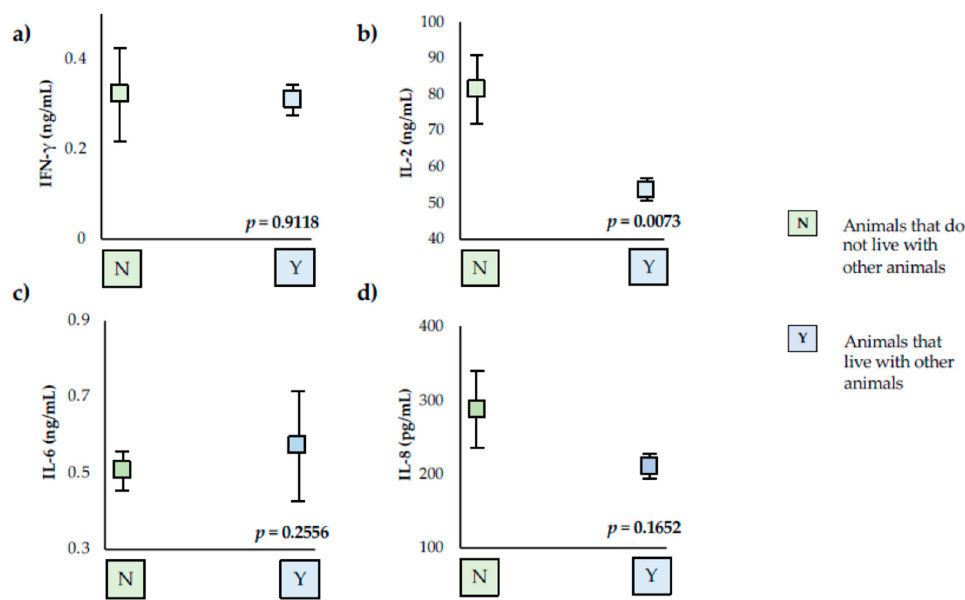
Figure 1. Serum levels of the cytokines studies in animals that do not live with other animals (N) and that live with other animals (Y). ( a ) Interferon gamma (IFN- γ ), ( b ) Interleukin 2 (IL-2), ( c ) Interleukin 6 (IL-6), and ( d ) Interleukin 8 (IL-8). Squares represent mean values for each group analyzed, and vertical lines represent standard deviation. The values for IL-8 are pg/mL, and for IFN- γ , IL-2 and IL-6, they are ng/mL. Each cytokine value possessing different letters differs significantly ( p < 0.05). Significant differences were also observed according to boxer breed, Ibizan hound, and other purebreds, and crossbreds presented statistical differences in IFN- γ , IL-2, and IL-8 serum levels (Figure